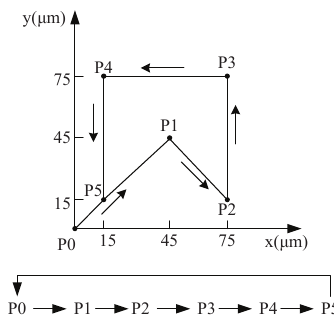
Figure 16. Coordinates and trajectory of six points for validation.